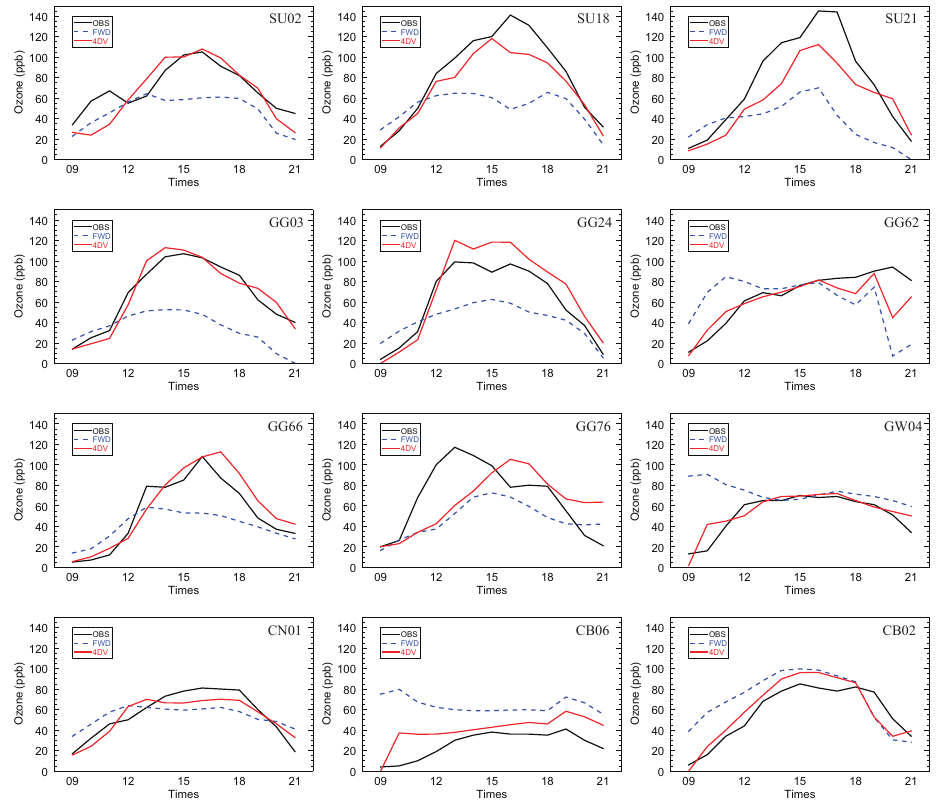
Figure 13. Time variations of surface ozone concentration at selected sites whose specific locations are marked by red filled triangles in Fig. 1 during daytime on 5 August. Black solid lines are observed results, and blue bashed and red solid lines indicate simulated results from the FWD and 4DV, respectively.